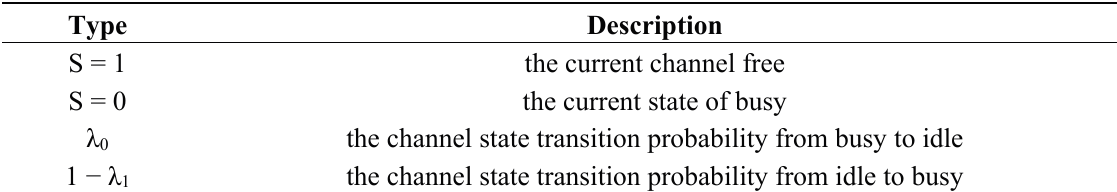
Table 4. Parameters of Gilbert-Elliott Markov